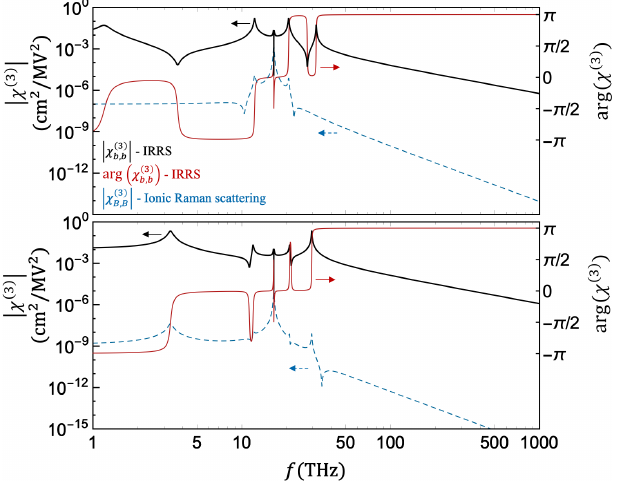
FIG. 4. Simulated magnitude (black) and phase (red) of the 3 Þ third-order susceptibility due to IRRS χ ð in SrTiO 3 when b;b the highest-frequency Γ − 5 ð E IR phonon is resonantly excited u Þ 16 . 40 THz). (a) χ ð 3 Þ 2; 1 ; − 1 ; 2 Þ exhibits coupling to the ( f xxxx ð IR ¼ Γ þ Γ þ 1 ð A 1 g Þ and 2 ð B 1 g Þ Raman phonons. The difference and sum frequencies that identify peaks are 12.18 and 20.62 THz for the Γ þ Γ þ 1 ð A 1 g Þ phonon, and 1.19 and 31.61 THz for the 2 ð B 1 g Þ 3 Þ 2; 1 ; − 1 ; 2 Þ exhibits coupling to the two phonon. (b) χ ð yxxy ð Γ þ 4 ð B 2 g Þ phonons. The difference frequencies are 3.38 and 11.88 THz, while the sum frequencies are 29.42 and 20.92 THz. Also shown (dashed), the corresponding magnitude of the third-order susceptibility due to the anharmonic lattice 3 Þ potential (ionic Raman scattering) χ ð B;B